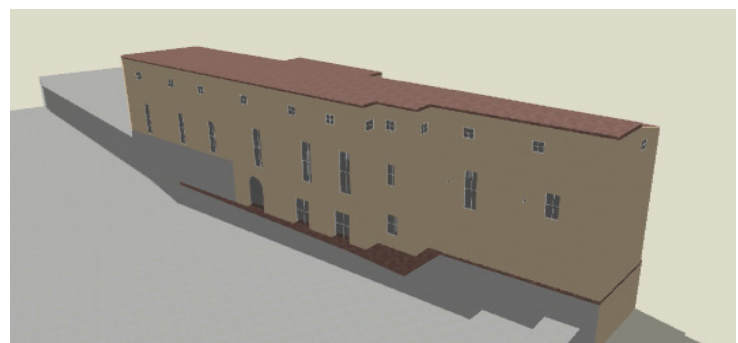
Figure 6. Model of the “Ridola” building.